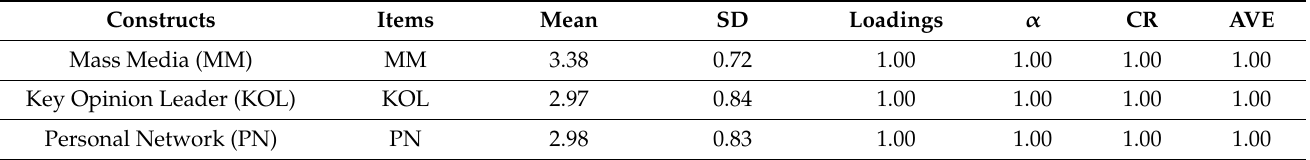
Table 2. Results for the measurement